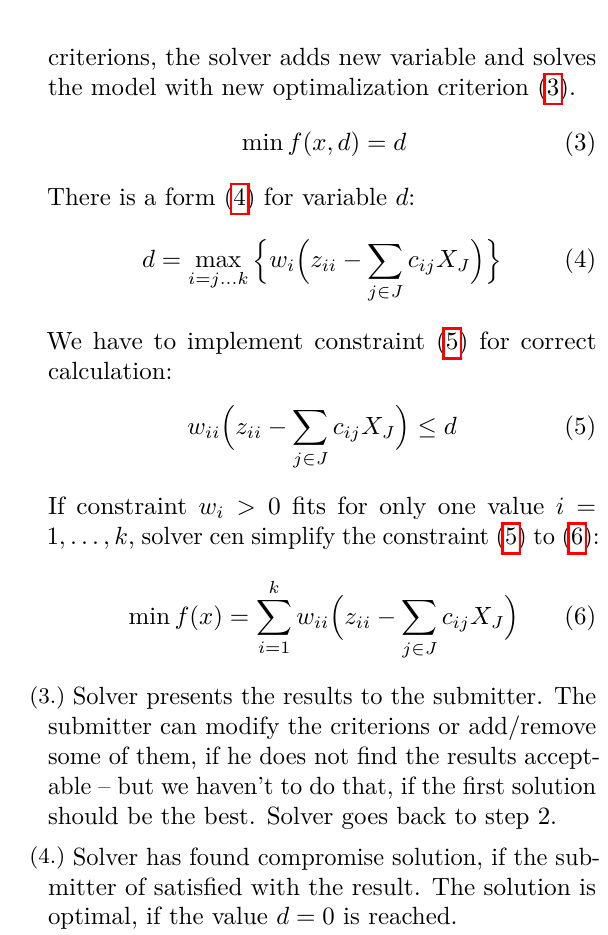
Figure 1. Suggestion of RS, source: Správa železnic